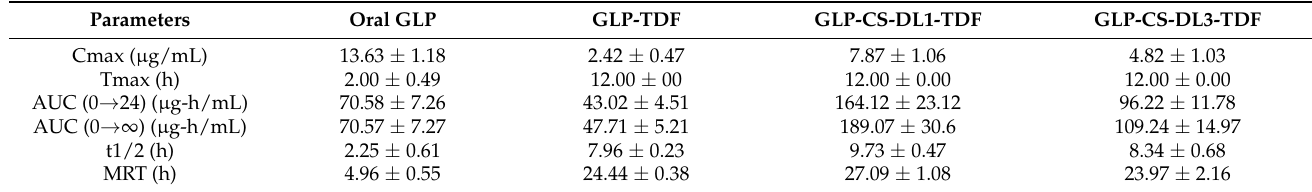
Table 7. Effect on blood glucose levels in STZ-induced diabetic rats (mean ± SD).